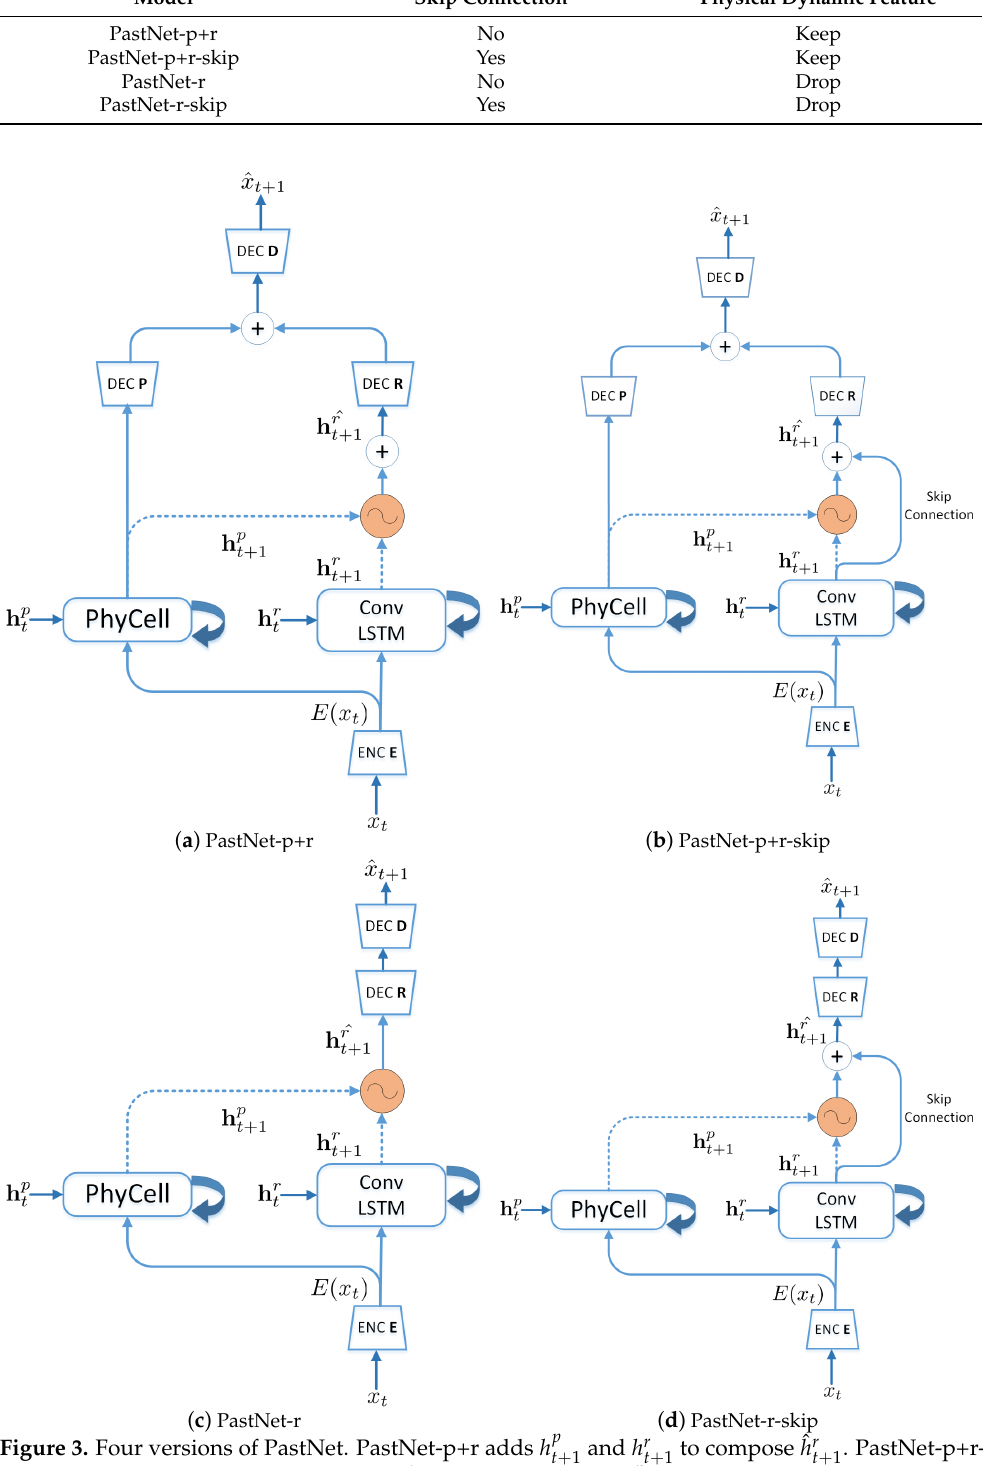
and h r to compose ˆ h r . PastNet-p+r- t + 1 t + 1 t + 1 and ˆ h r . PastNet-r drops h p after the attention gate and only t + 1 t + 1 t + 1 and t + 1